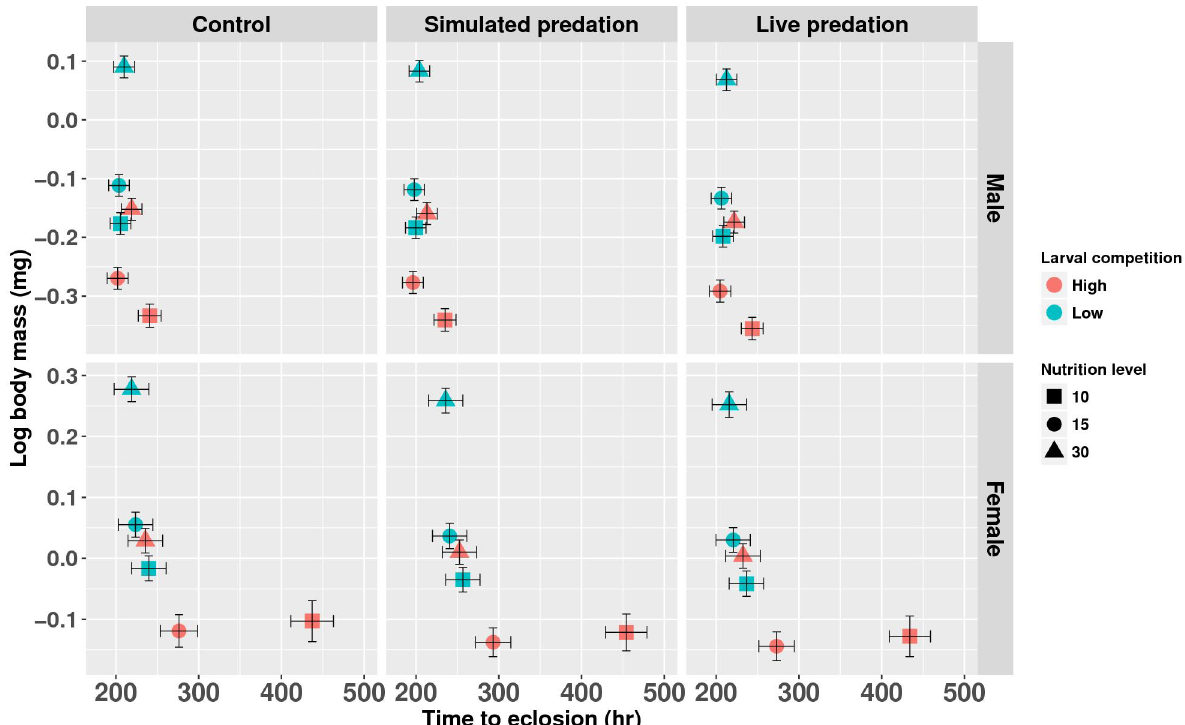
Fig 2. Time to eclosion and adult body mass. Bivariate plot of least squares means ( ± SE) for mean adult body mass and mean of median time to adult eclosion for larval nutrition × intraspecific competition across replicate containers. Data have been presented separately for male and female mosquitoes across three predation treatments. Data were statistically tested using a mixed model MANOVA and significant effects are described in Table 2.